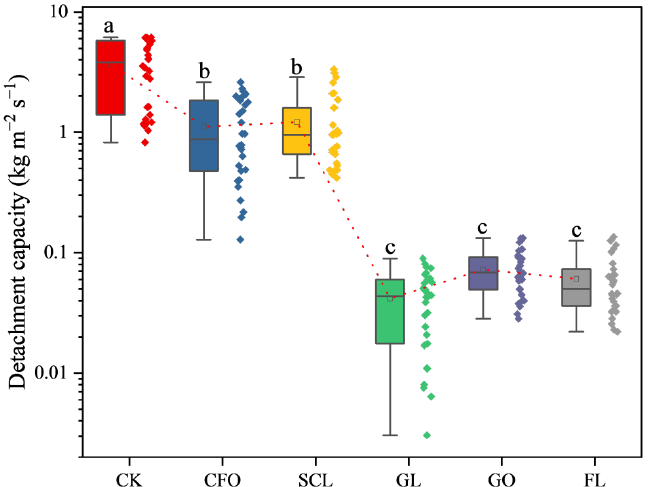
Figure 3. Soil detachment capacity of different land use types. Notes: Different letters indicate significant differences in soil detachment capacity among the different land use types ( p < 0.05). CK, bare land; CFO, orchard with no cover; SCL, farmland; GL, grassland; GO, orchard with grass cover; FL, forest.